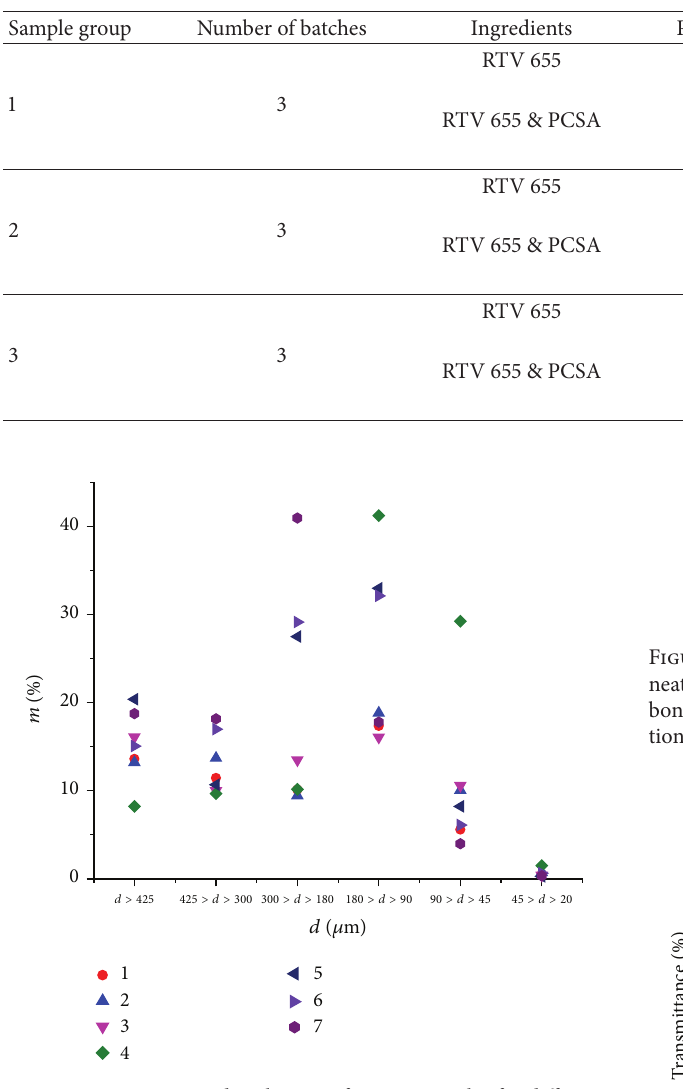
Figure 1: Percent mass distribution of PCSA particles for different diameterrangesforsevenseparatesynthesisbatches,afterpulveriza- tion stage ( 𝑡 = 60 sec). The majority of PCSA microparticles created by step-pulse pulverization technique were greater than 90 𝜇 m in diameter.